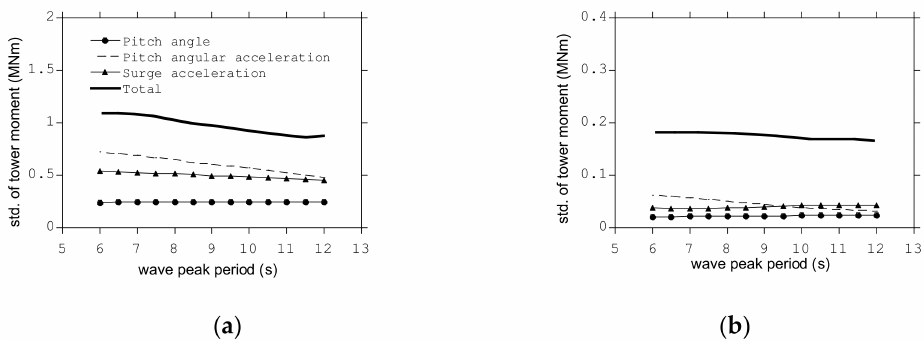
Figure 11. Standard deviation of the fore-aft tower bending moment as function of wave period: ( a ) tower base; ( b ) tower top.